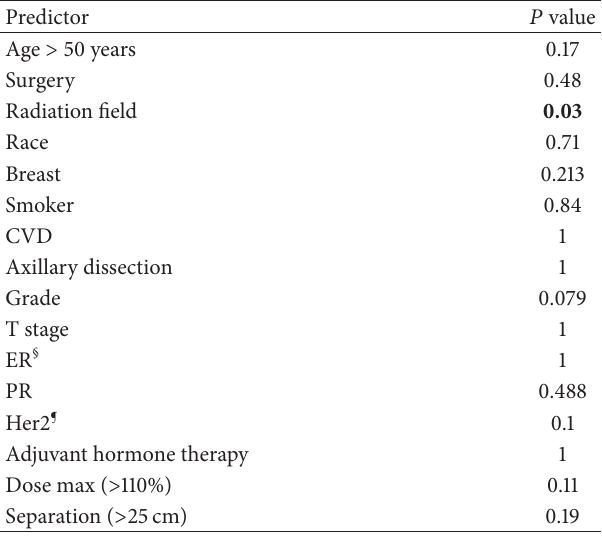
Table 3: Radiation dermatitis univariate